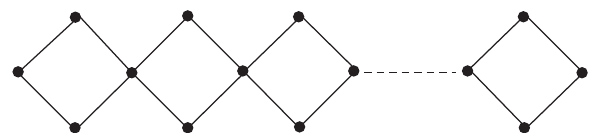
Figure 2: Example of the paracactus chain graph of cycles for m � 4 and n � n .